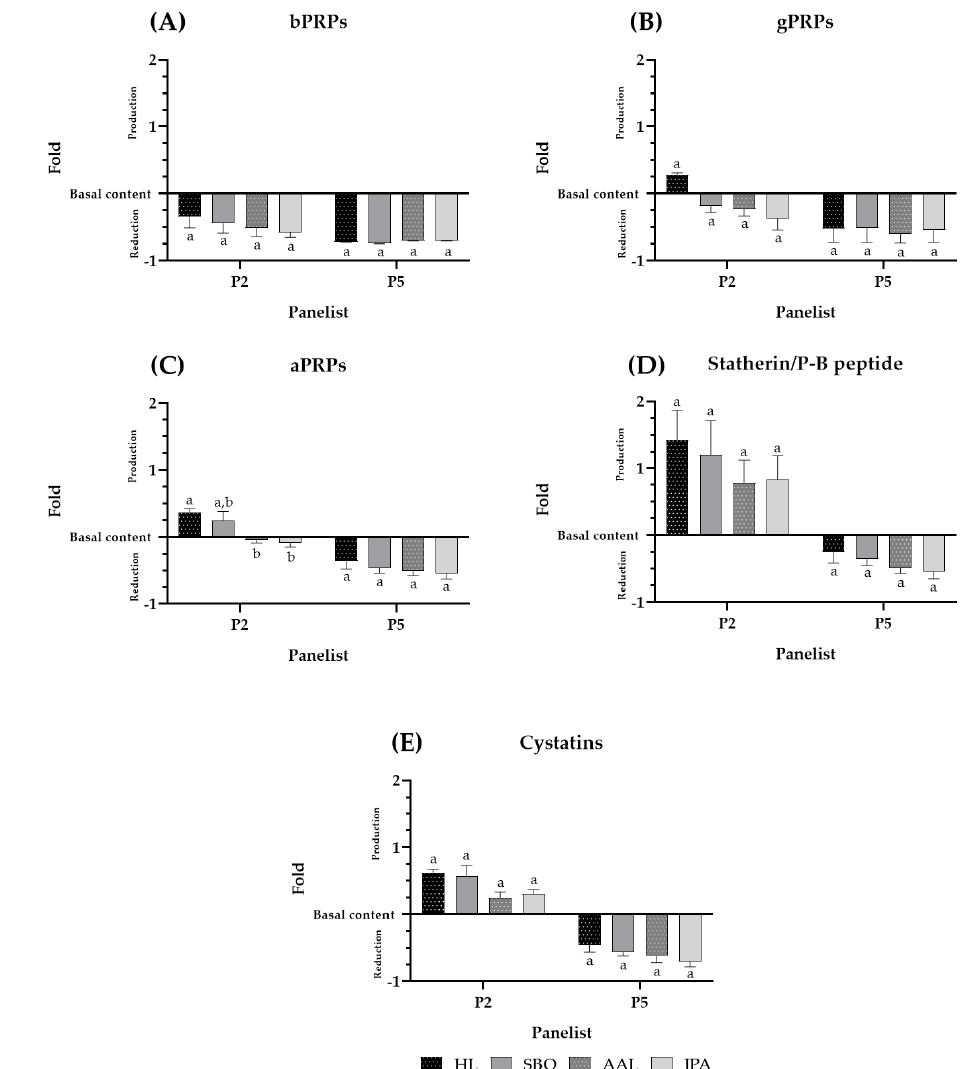
Figure 2. SP family behavior upon beer intake (Coruja Hoppy Lager (HL), Super Bock Original (SBO), Coruja American Amber Lager (AAL), and Coruja India Pale Ale (IPA), respectively. ( A – C ) indicate the PRP family, bPRPs, gPRPs, and aPRPs, respectively. ( D ) statherin and P-B peptide, and ( E ) cystatins upon beer intake. The interaction between the SP and PC compounds is presented by the fold of total SP precipitated, for each panelist, during beer sensorial analysis. Fold represents how many times SP reduction or production occurs regarding the previous beer intake of saliva collection for each panelist. Values with different letters within each panelist are significantly different ( p < 0.05).